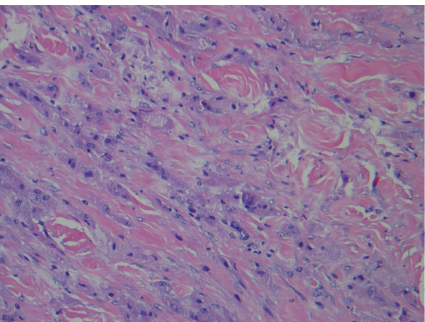
Figure 1: (Hematoxylin and eosin original magnification, 400x). The malignant granular cell tumor was composed of multiple large spindle cells with abundant granular cytoplasm and pleomorphic, hyperchromatic nuclei with prominent nucleoli and scattered mitotic figures.